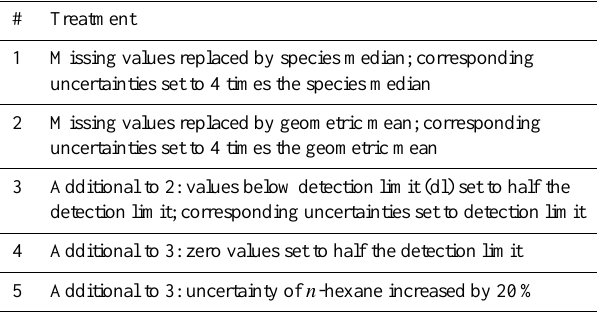
Table 1. Different treatments of missing values, values below the detection limit, and zero